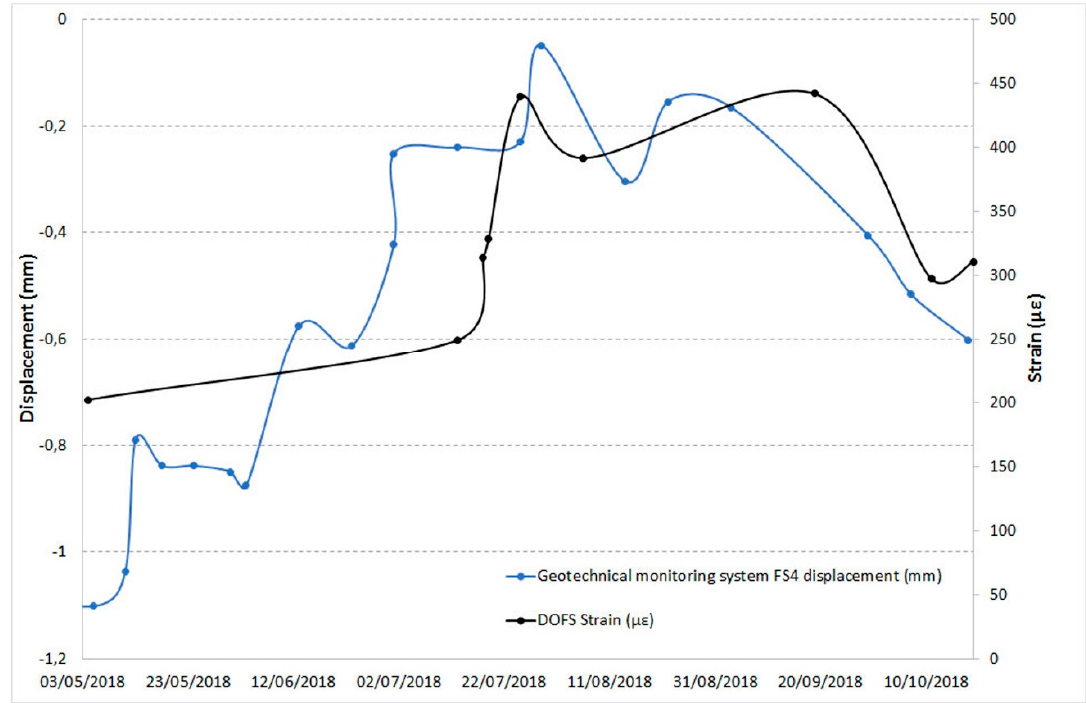
Figure 28. Comparison between the FS4 crackmeter displacements and DOFS strain values in the same area.